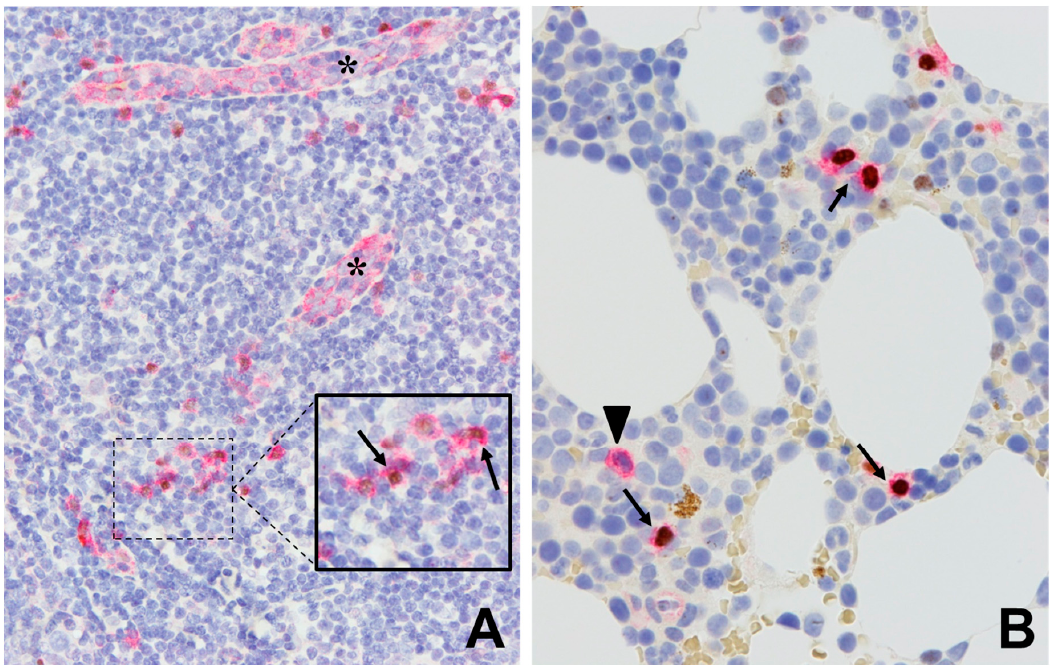
Figure 3. Immunohistochemistry using antibodies against CD123 (red signal, surface/cytoplasmic) and TCF4 (brown signal, nuclear). ( A ) Normal tonsil showing CD123+/TCF4 − expression on endothelial cells (asterisks), with a few scattered plasmacytoid dendritic cells showing CD123+/TCF4+ expression (arrow). ( B ) Bone marrow with scattered CD123+/TCF4 − myeloid cells (arrowhead) as well as CD123+/TCF4+ plasmacytoid dendritic cells (arrows). ( A and B . Main figures at 200× magnification (inset, 400×), hematoxylin counterstain).